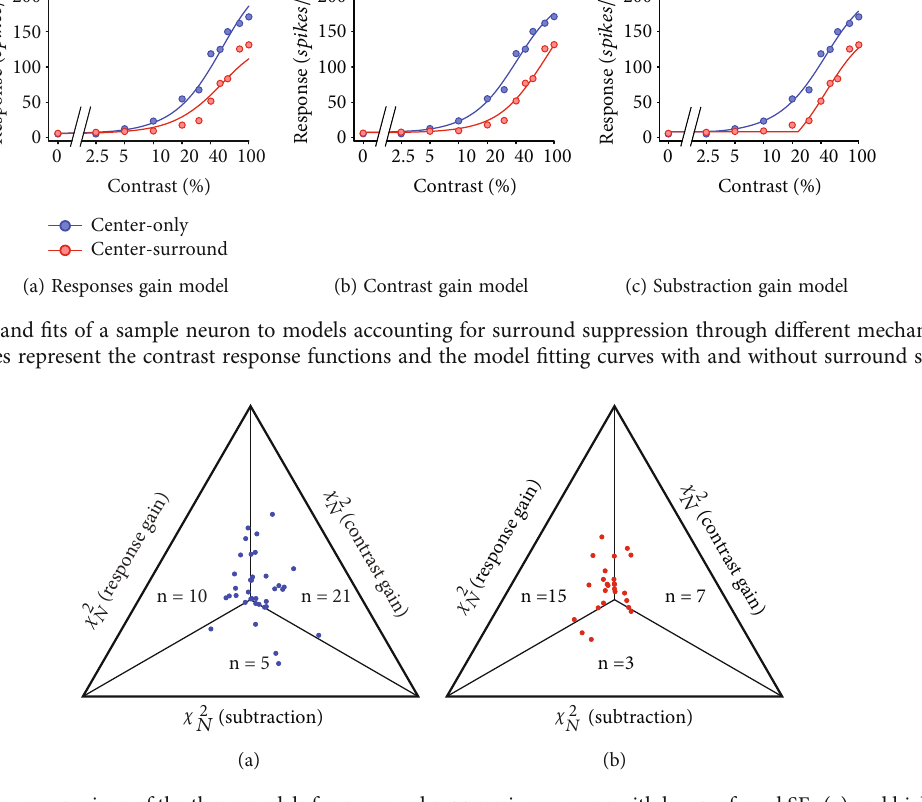
Figure 10: A three-way comparison of the three models for surround suppressive neurons with low preferred SFs (a) and high preferred SFs (b). Axis (lengths of sides of the triangle) units are normalized to make the total χ 2 N of each model equal 1. The distance of a point from each bounding axis represents its χ 2 N for the fi t to that model. Because the lowest χ 2 N value indicate the best fi t, points near a bounding axis represent neurons for which model performed better than the